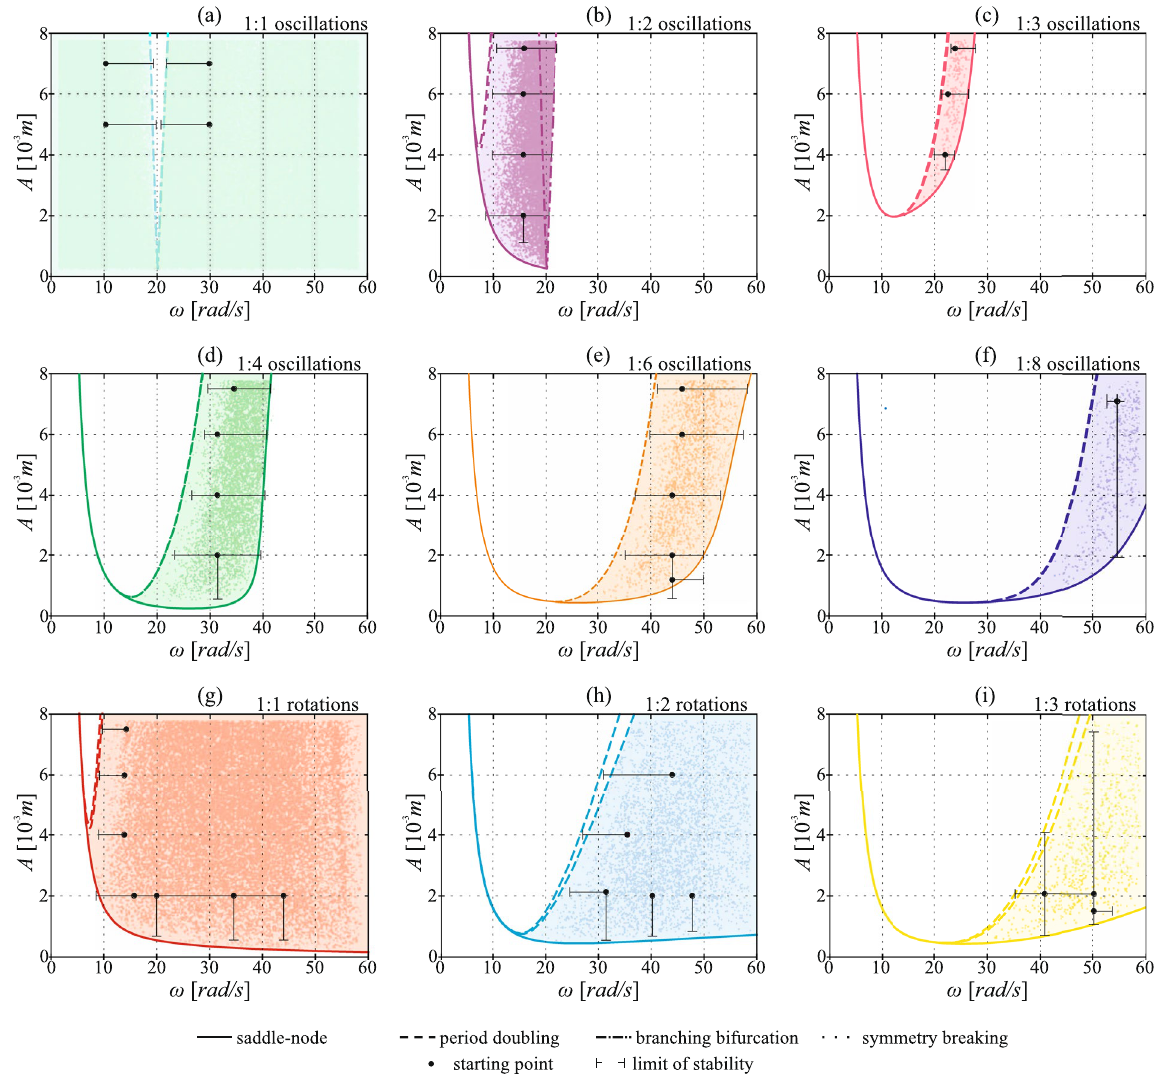
Figure 3. Comparison between the ranges of stability obtained using the path-following method (colour lines), the sample-based approach (dots) and the experimental investigation (black lines). Each panel correspond to a different solution. Colour line type depicts the type of